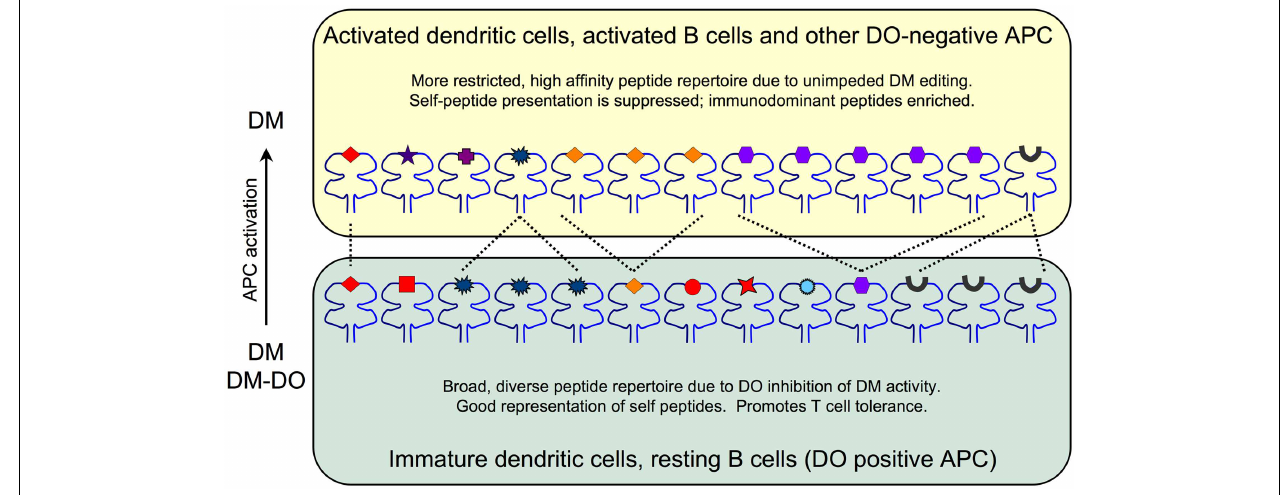
including CLIP (black peptide) are well represented. Activated DCs and B cells and other DO-negative APC (top) are enriched for DM due to DO downregulation and thus display a more focused and high stability peptide repertoire. Self-peptide presentation including CLIP is reduced at the expense of high stability peptide presentation promoted by fully active DM